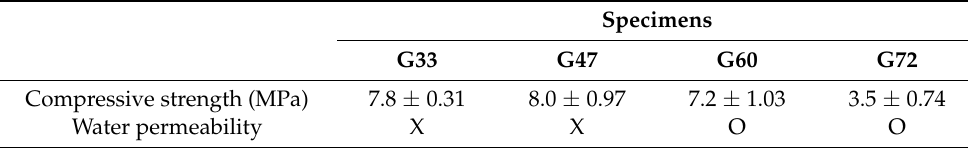
Table 3. Compressive strength and water permeability of the specimen.